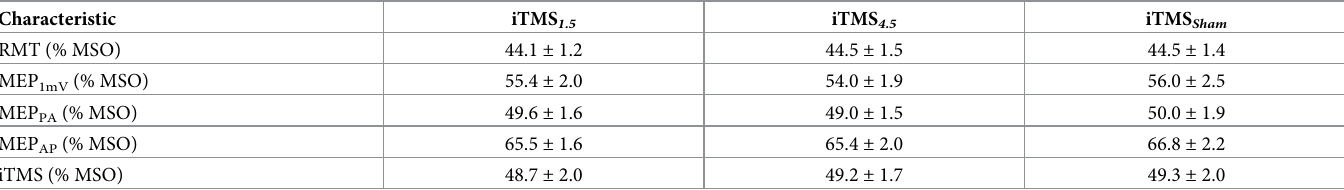
Table 1. Baseline characteristics (mean ± STD) between iTMS sessions.